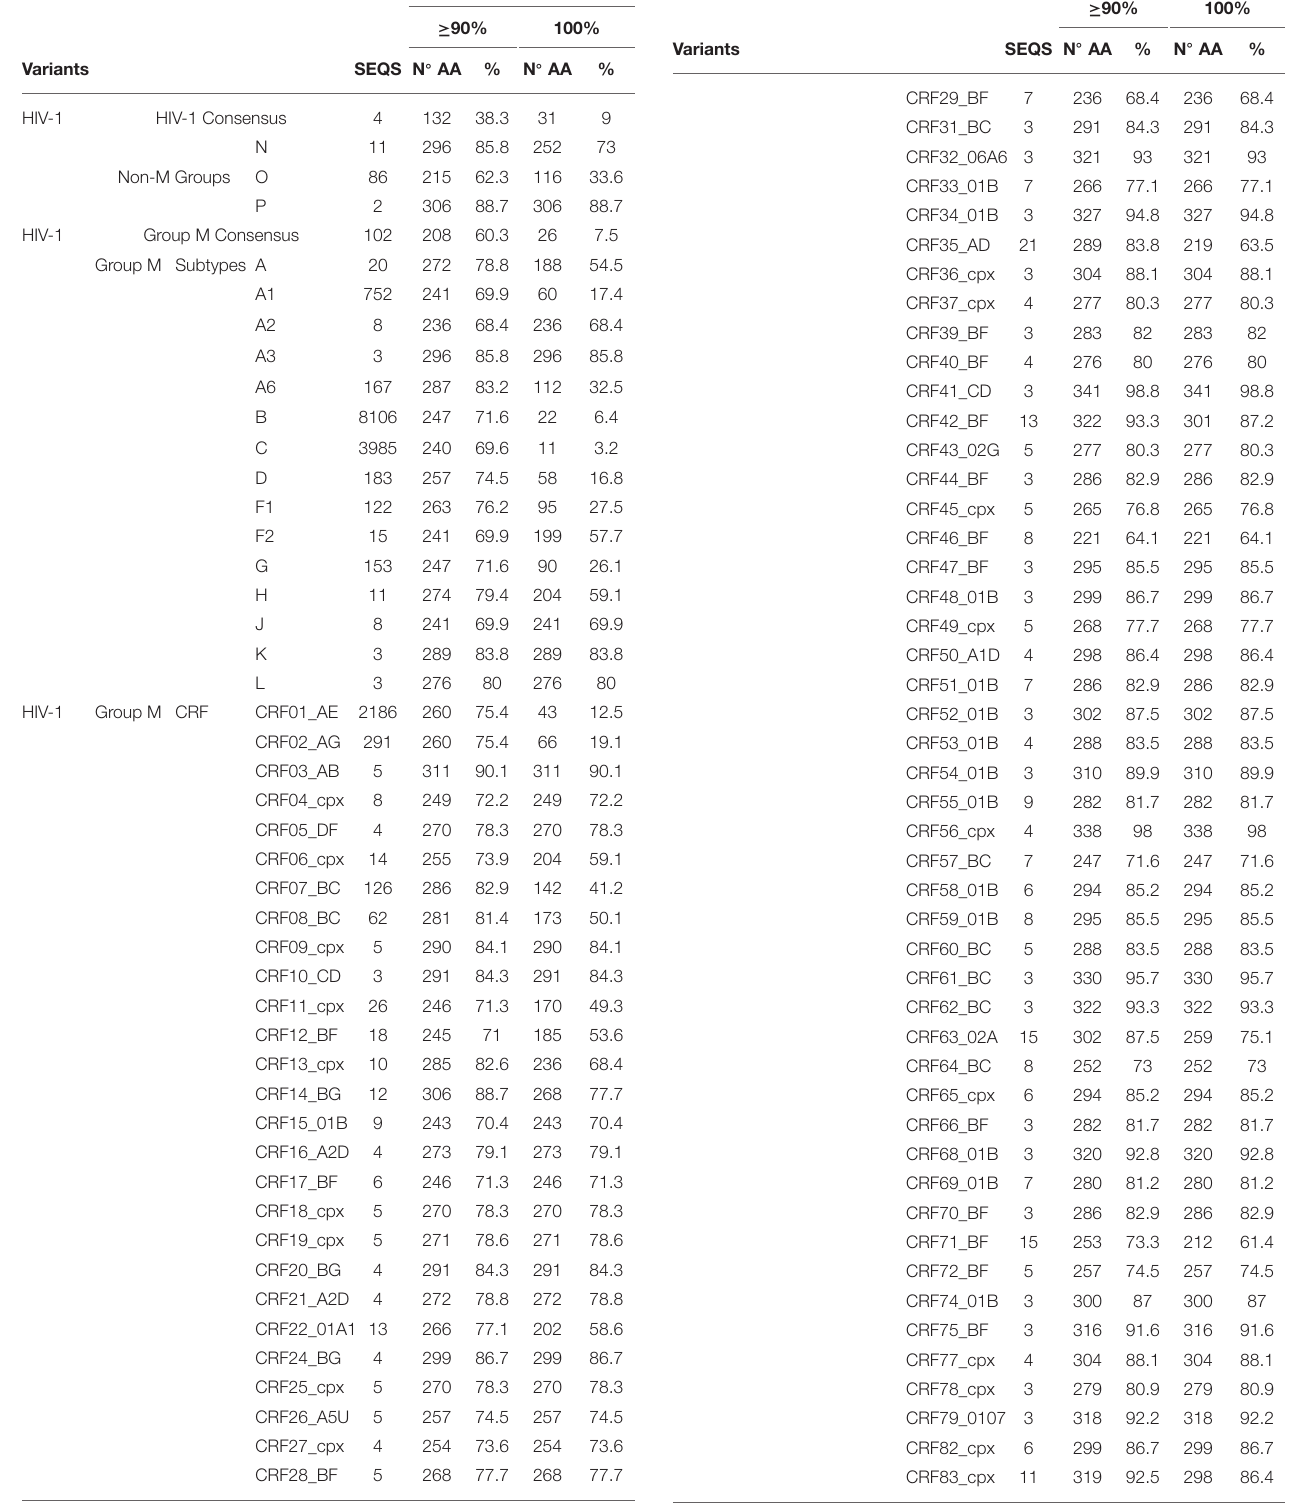
Conservation ≥ 90%